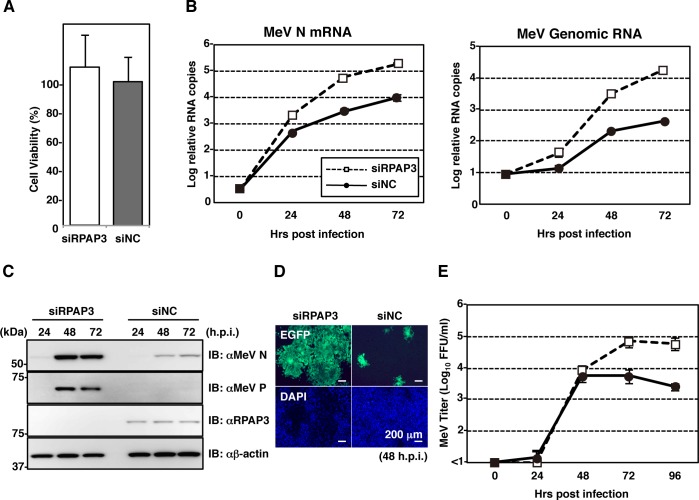
RPAP3 knockdown enhances MeV propagation.(A) At 96 h post-transfection with siRPAP3, cell viability was determined and calculated as a percentage of the viability of cells transfected with siNC. (B-E) At 48 h post-transfection with either siRPAP3 or siNC, A549/hSLAM cells were infected with rMeV/eGFP at a MOI of 0.05. Total cellular RNA and cell lysates were collected at 0, 24, 48 and 72 hpi, and relative levels of viral RNAs and proteins were analyzed by qPCR (B) and immunoblotting (C), respectively. (D) At 48 hpi, the cells were observed under a fluorescence microscope. (E) Supernatants were collected at 0, 24, 48, 72 and 96 hpi, and the infectious titers were determined by plaque assay. Error bars indicate the standard deviations of triplicate wells.